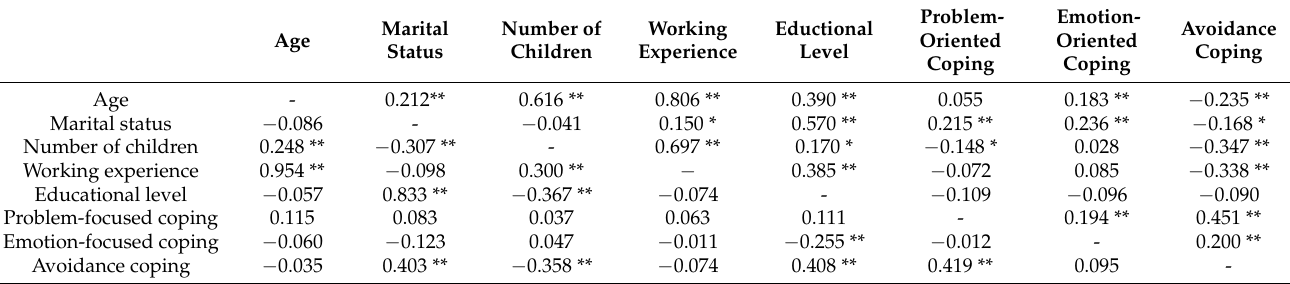
Table 3. Correlation matrix for the tested variables.